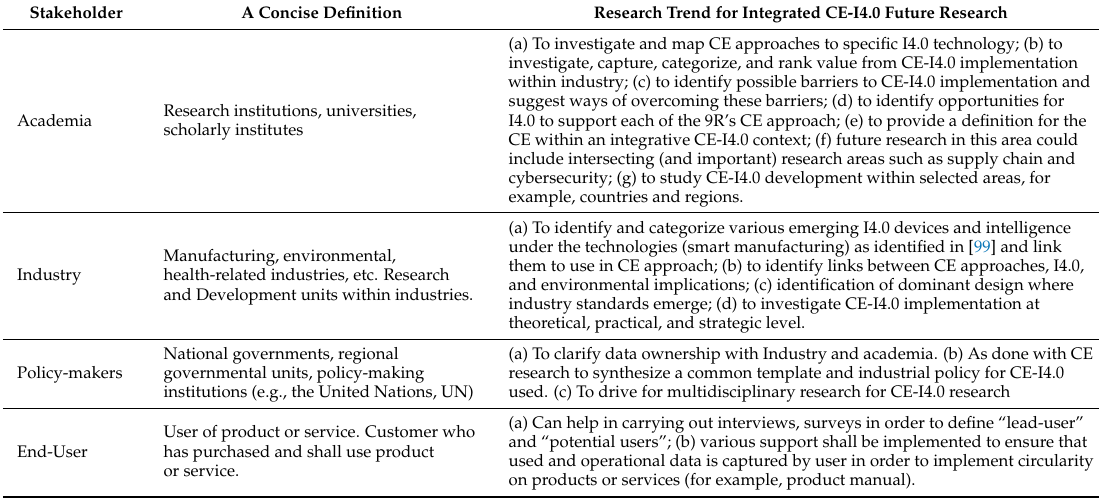
Table 7. Research trends for various stakeholders for future